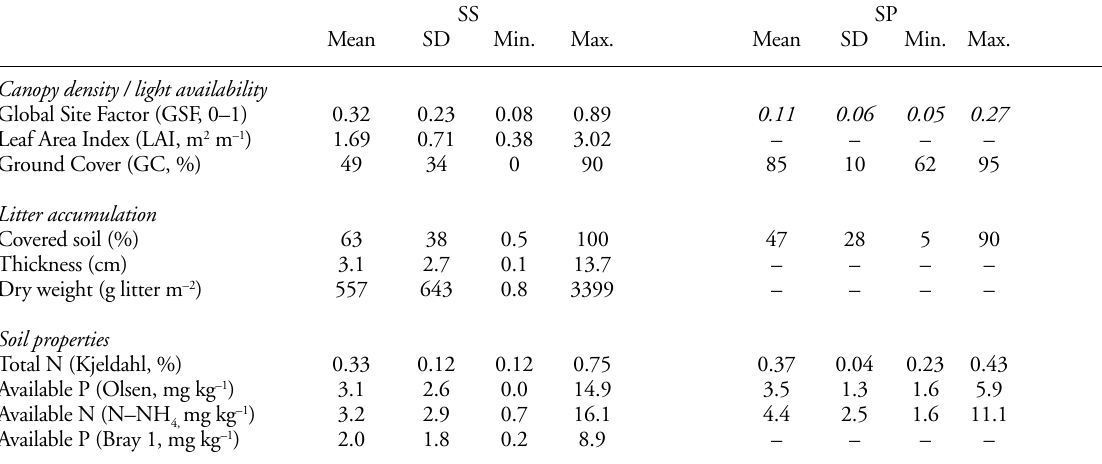
Table 1. Mean, standard deviation, minimum, and maximum values for the canopy density, litter accumulation, and topsoil variables measured in the two studied forests (SS = southern Spain site at Los Alcornocales Natural Park ; SP = southern Portugal site at Sudoeste Alentejano e Costa Vicentina Natural Park ). Data estimated using linear regression (see text) are in